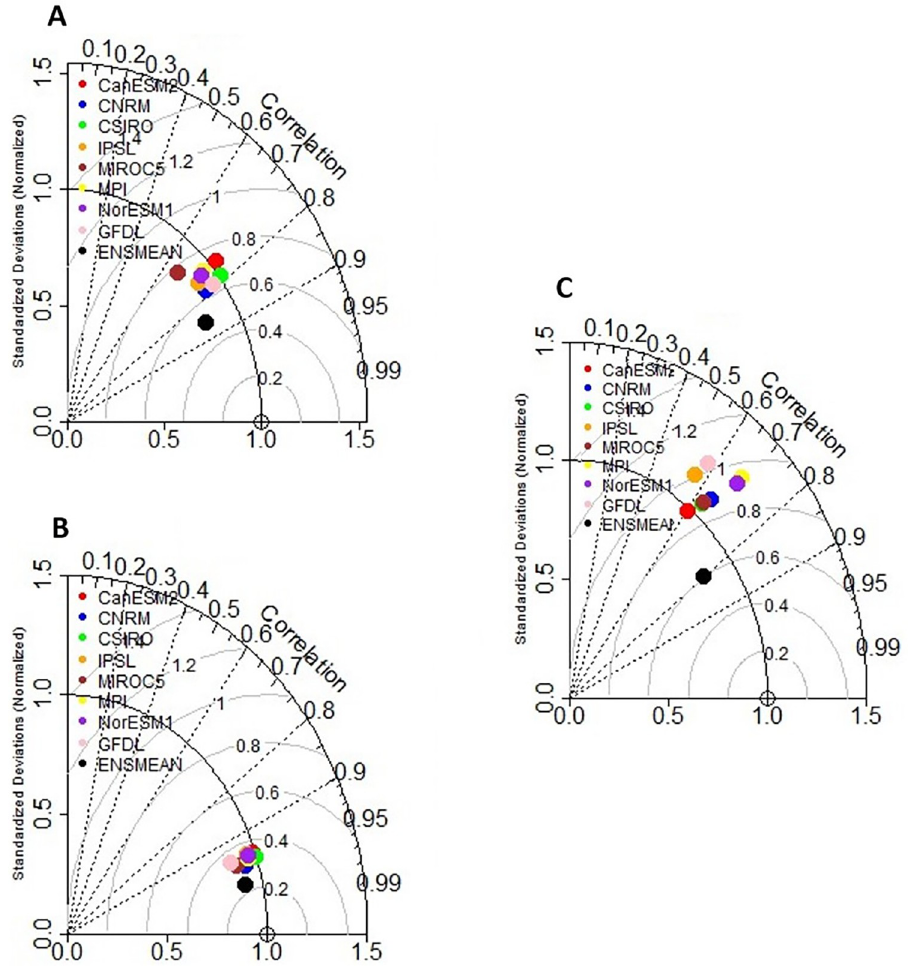
Fig 4. Taylor diagrams for (A) maximum temperature, (B) minimum temperature and (C) precipitation, comparing observations with CMIP5 models and ensemble mean simulations for Olifant River Catchment for the period 1976– 2005.